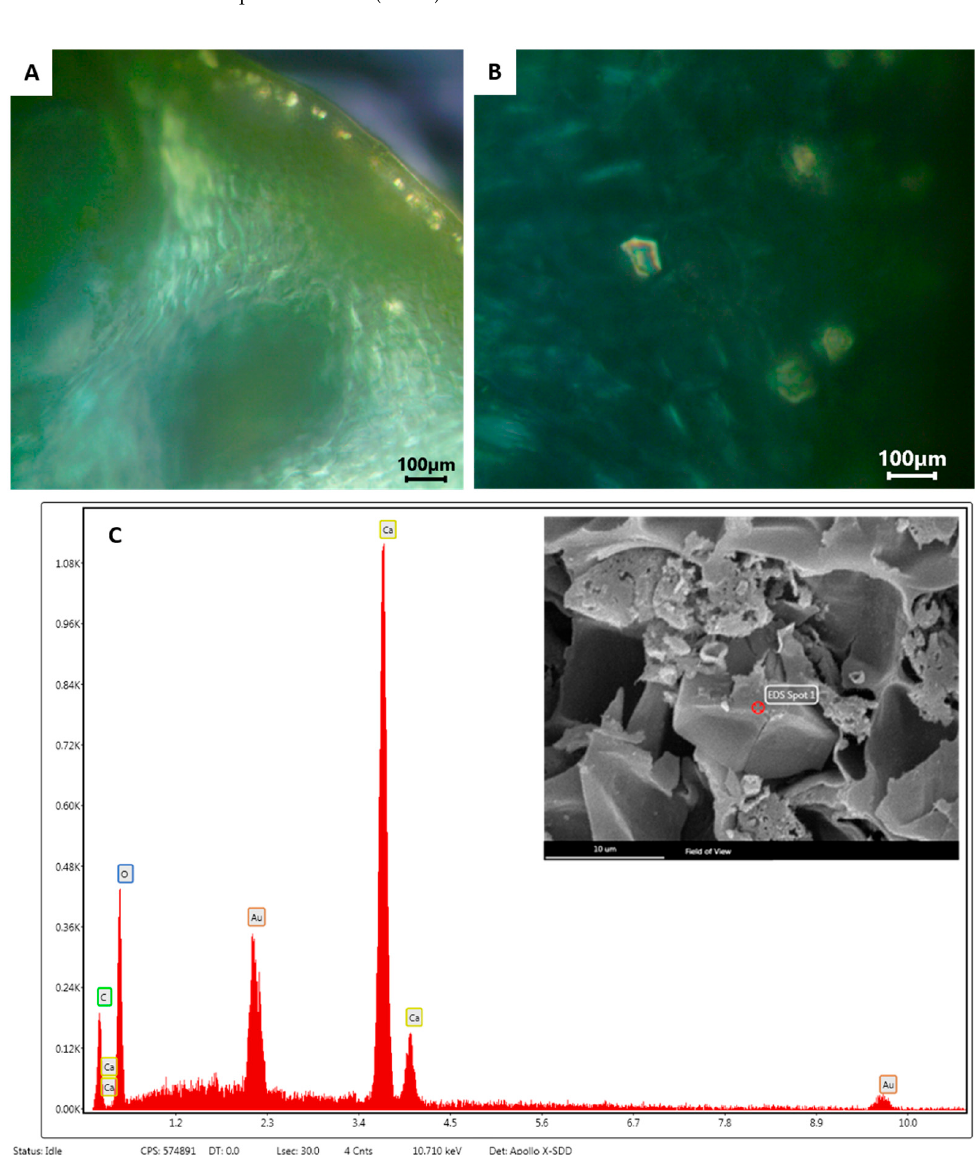
Data are the mean ± SD expressed in mm ( n = 30).